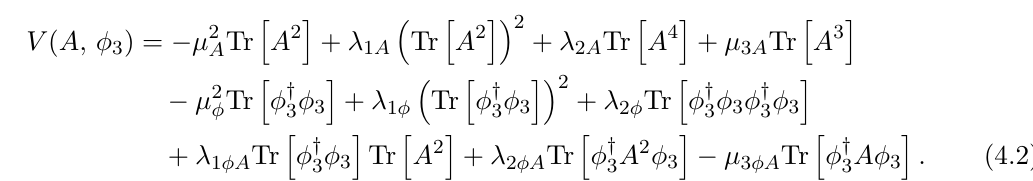
Table 4. The content of fermions, scalar fields and gauge bosons in the SU(5) × SU(3) H model is shown in the group representation, (SU(5) , SU(3) H ) and (SU(3) c , SU(2) L ) has three generations. The superscript R denotes the real field, while the other fields are complex fields. Some components of the fake GUT Higgs scalars φ 3 and A become the longitudinal modes of the fake GUT gauge boson when SU(5) × SU(3) H is broken to G SM (see text). potential